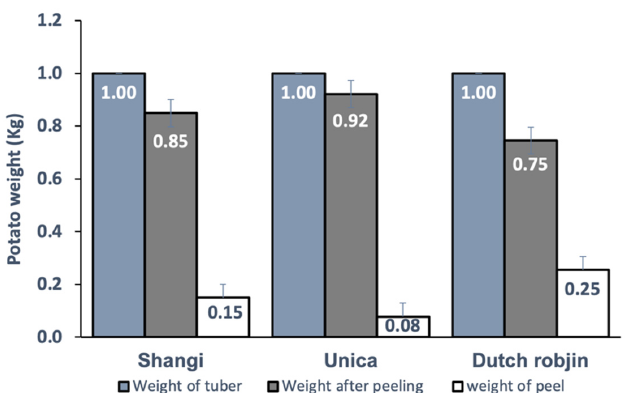
Figure 1. Percentage peeling loss of the three varieties (Shangi, Unica, and Dutch Robjin).